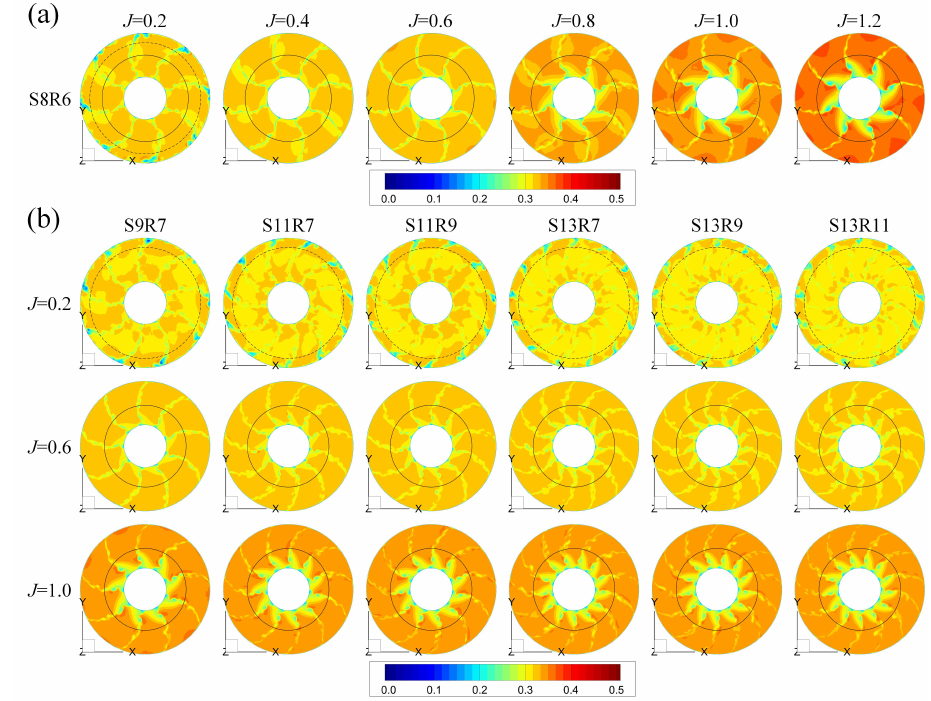
Figure 21. Velocity magnitude V m at z = − 0.3 D r slice, where the radii of the dashed circle and the solid circle are 0.45 D r and 0.35 D r , respectively. ( a ) PJP model S8R6, ( b ) derived PJP models ID